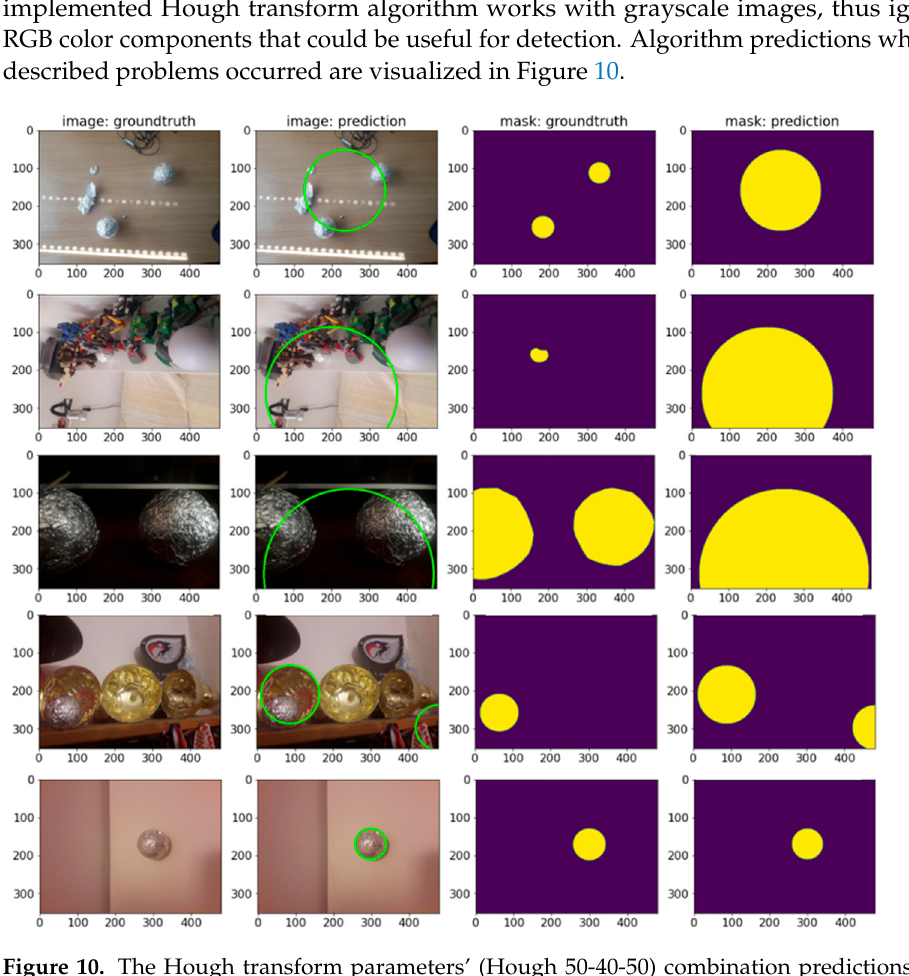
Table 6. Hough transform DICE and IoU scores on TEST and TEST AUG sets for di ff erent parame- ters combinations, where p stands for parameter, minR for min radius and maxR for max radius. Best results are bold.